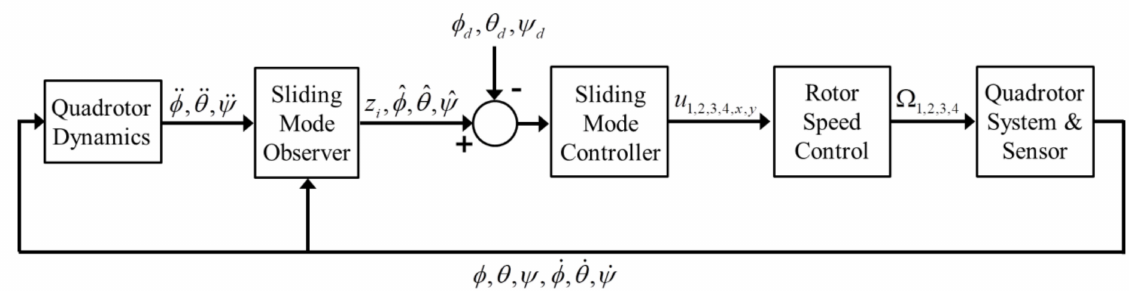
Figure 2. Control scheme of